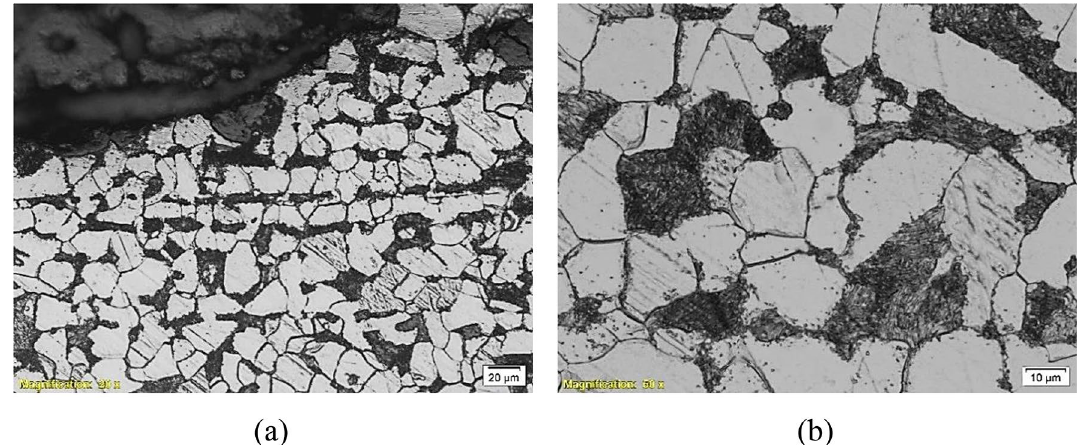
Figure 12. Microstructure of the failed elbow UB10-B11: ( a ) cross-section at external corroded surface, and ( b ) higher magnification view showing typical microstructure of carbon